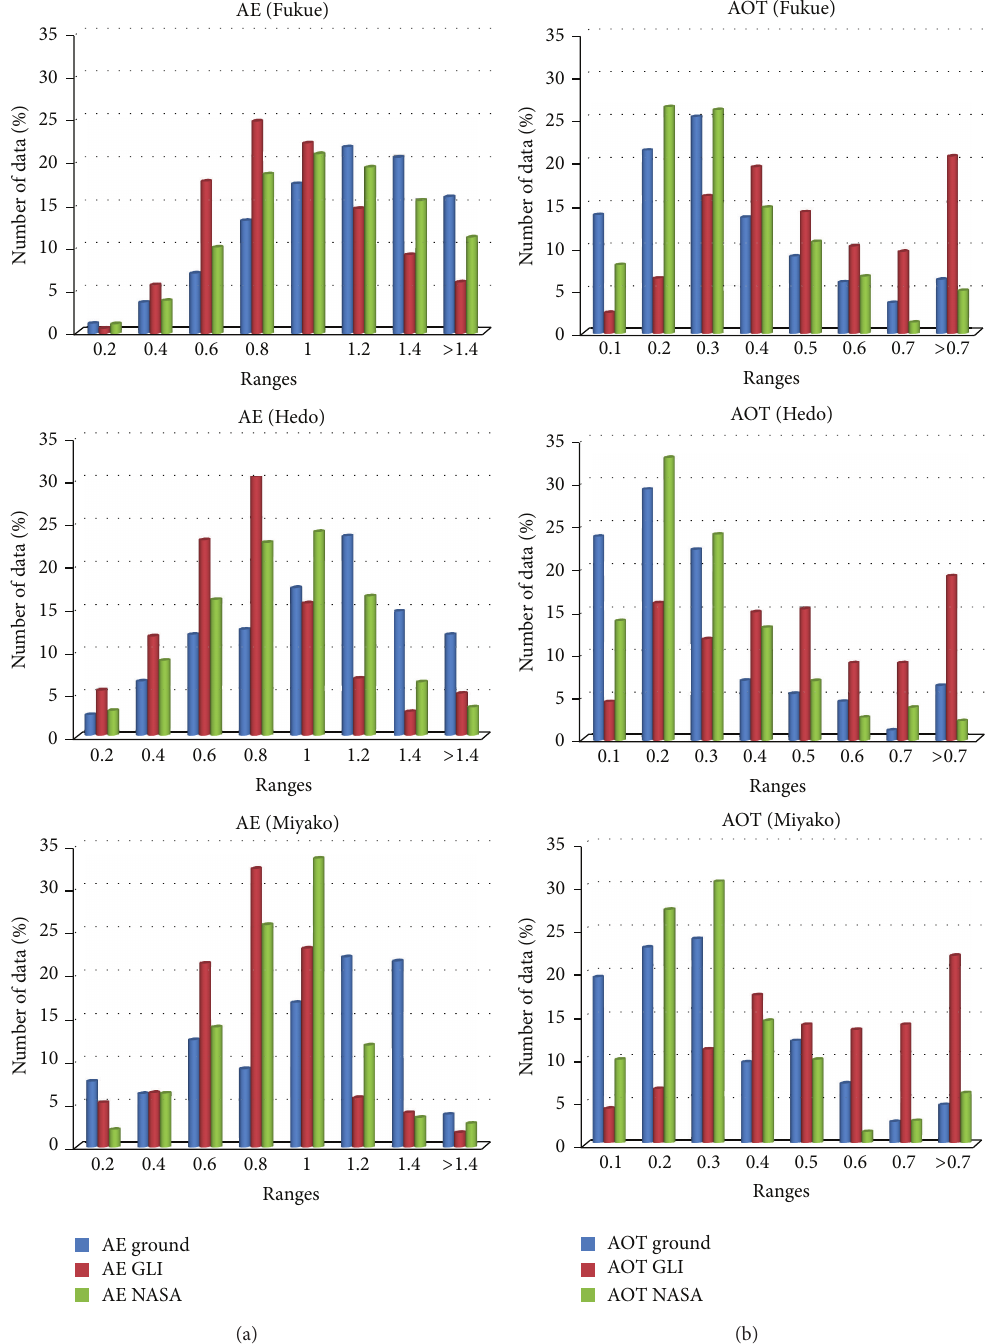
Figure4: Comparisonbetween thefrequency distributionof groundmeasurements and satellitederived (GLIfor theMODIS-GLI algorithm, NASA for the MODIS-NASA algorithm) aerosols properties (AE (a), AOT (b)).